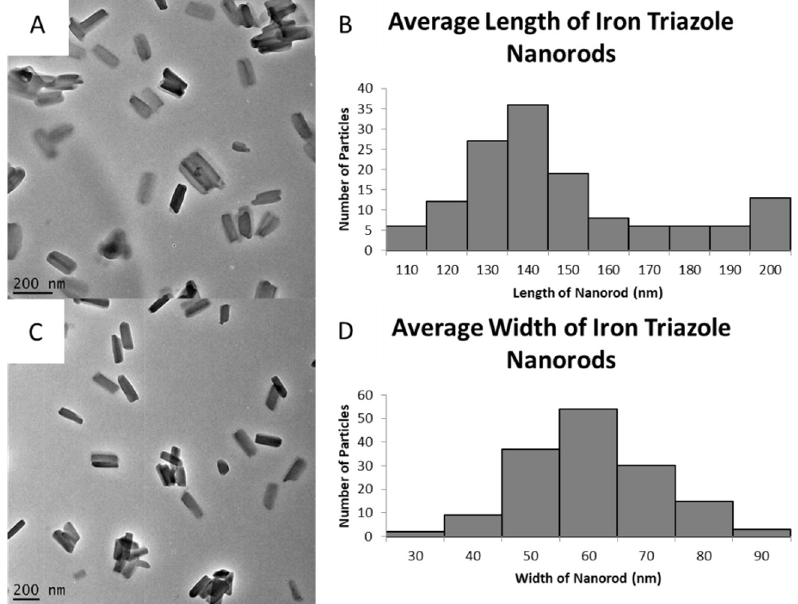
Figure 3. TEM images of particles that were obtained when precursors were separated within different vials and stirred for 5 min, Reaction 5. Both ( A , C ) are samples that were conducted with the same reaction conditions. ( B , D ) are average lengths and widths, respectively.